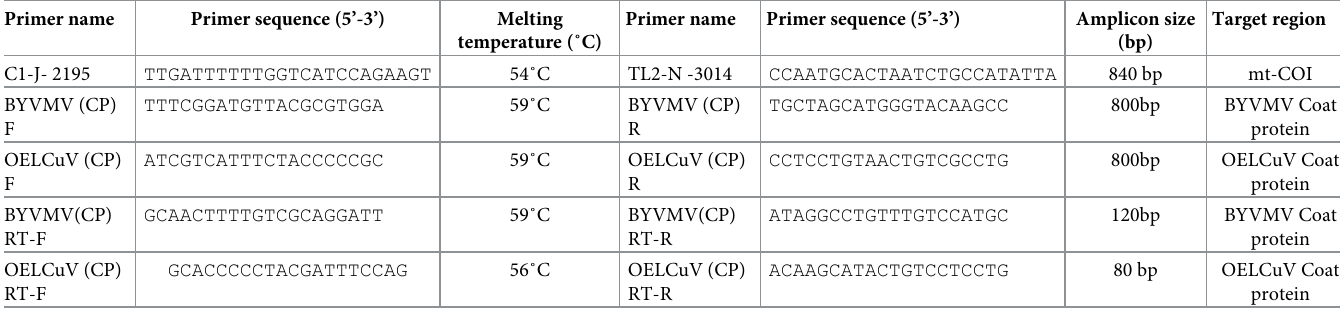
Table 1. List of primer pairs used in the